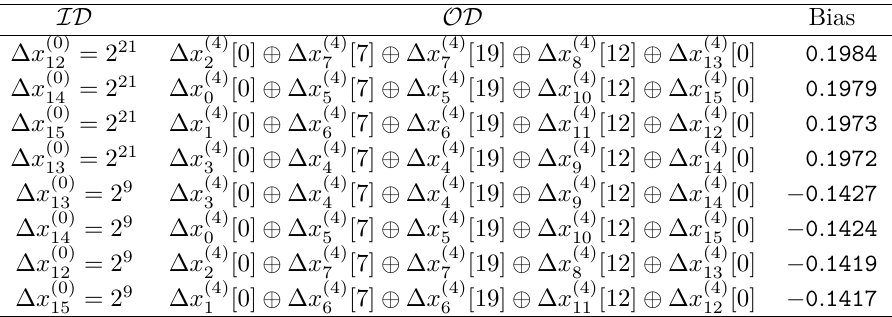
Table 5: Best multi-bit differentials for 4 rounds of